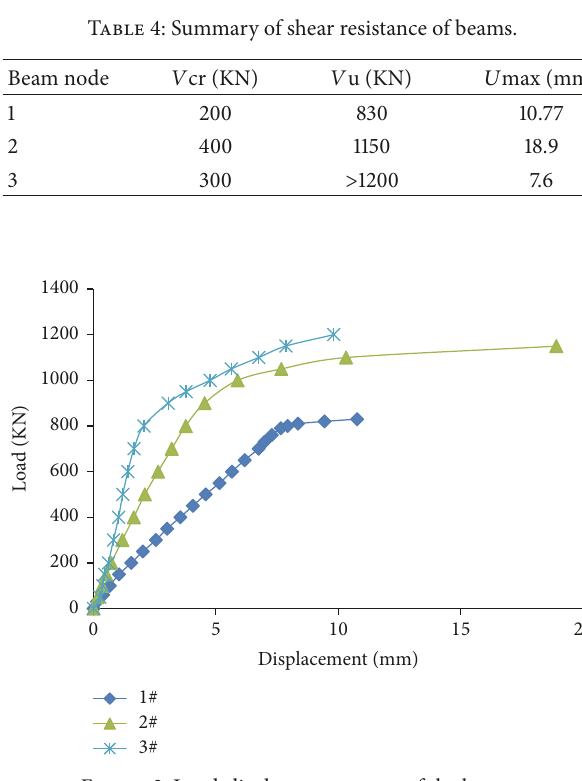
Figure 2: Load-displacement curve of the